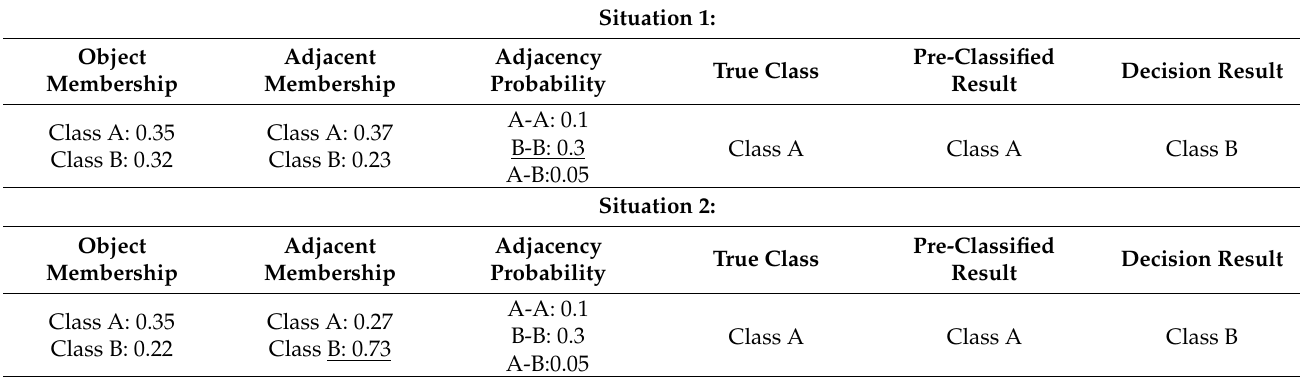
Table 3. Two situations demonstrate the objects misclassified by decision fusion. Problems causing the misclassification are marked in underline.